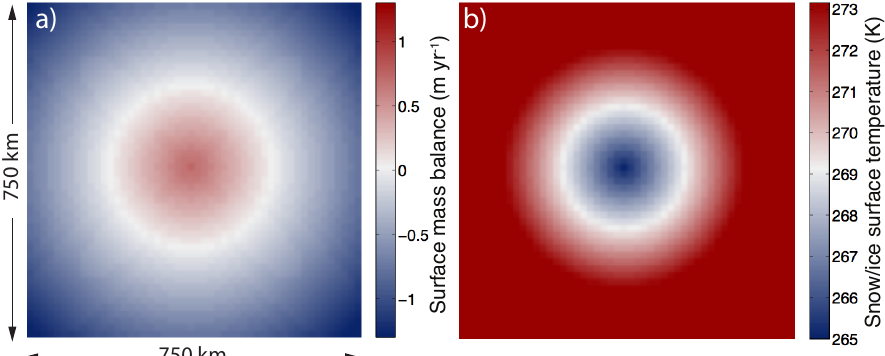
Fig. 1. The prescribed surface mass balance (a) and snow–ice surface temperature (b) forcing fields in the synthetic experiments.